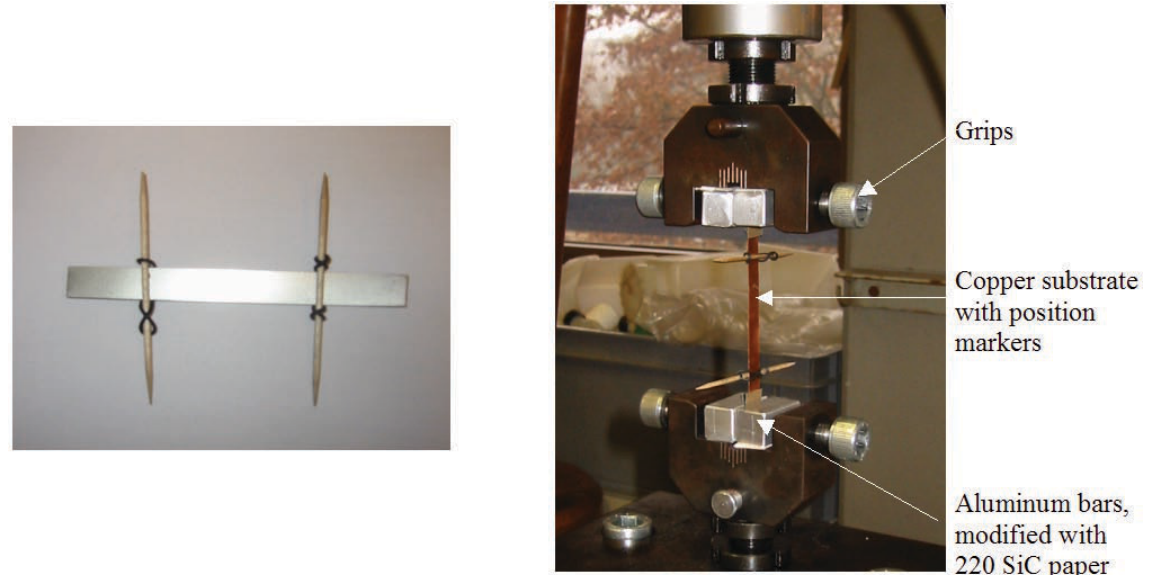
Figure 3. (Left): CuNi44 tape with position markers (toothpicks fixed with elastic bands). (Right): Tensile strength test arrangement for thin metal